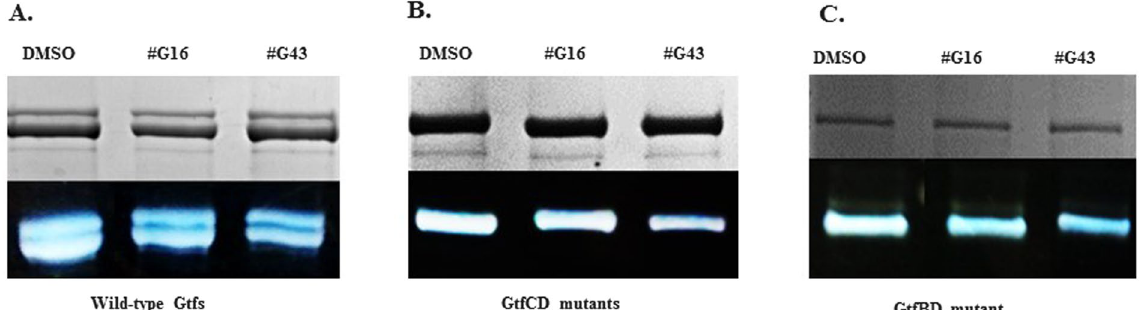
Figure 2. Gtf patterns of S. mutans UA159 and its mutant variants. Culture supernatants were prepared from S. mutans UA159 wild type and gtf double mutants, and then subjected to SDS-PAGE analysis with equivalent amount of proteins in each lane. The upper panel was stained with Coomassie blue to monitor the total protein amounts while the lower panel shows enzymatic activities of Gtfs with the treatment of the lead by the zymographic assay. The intensity of the bands were quantified using ImageJ in comparison to DMSO. ( A ) Effects of lead compounds #G16 and #G43 at 25 µ M on the activity of Gtfs from wild type S. mutans . ( B ) Effects of lead compounds #G16 and #G43 at 25 µ M on the activity of GtfB from S. mutans GtfCD mutants. ( C ) Effects of lead compounds #G16 and #G43 at 25 µ M on the activity of GtfC from S. mutans GtfBD mutants.